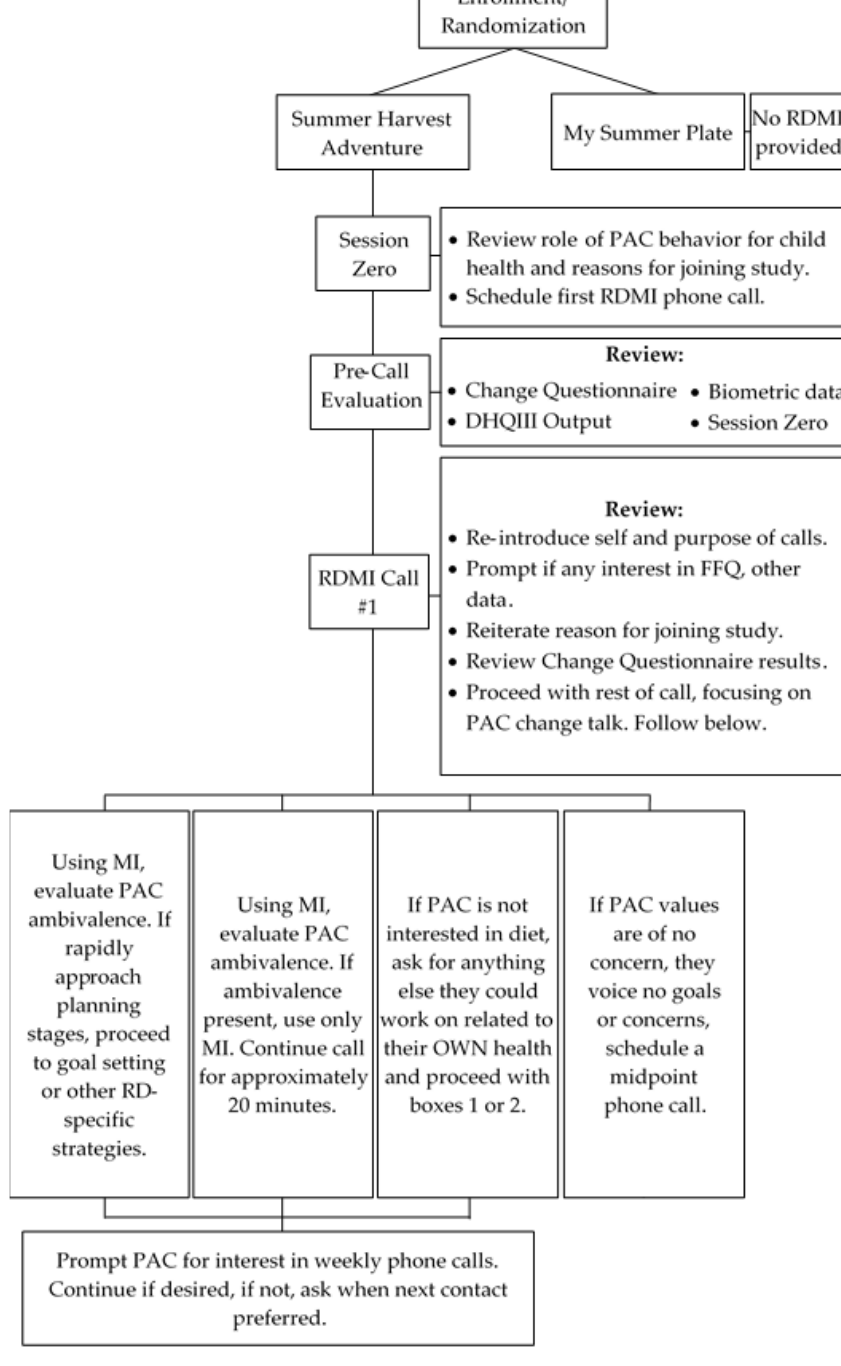
Figure 1. Overall Study Design and Protocol for